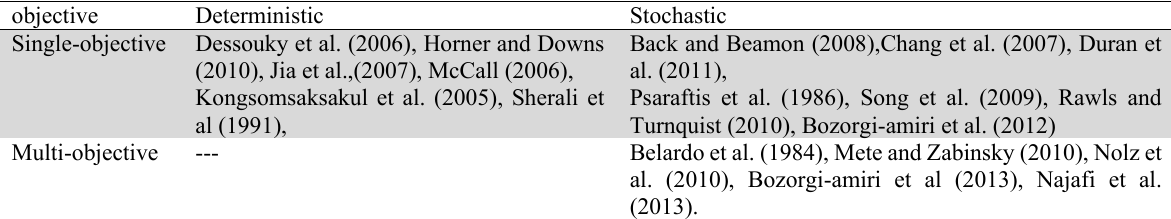
Structure of facility location models based on the data type and number of levels and objectives objective Deterministic Stochastic Single-objective Dessouky et al. (2006), Horner and Downs Back and Beamon (2008),Chang et al. (2007), Duran et (2010), Jia et al.,(2007), McCall (2006), al. (2011), Kongsomsaksakul et al. (2005), Sherali et Psaraftis et al. (1986), Song et al. (2009), Rawls and al (1991), Turnquist (2010), Bozorgi-amiri et al. (2012) Multi-objective --- Belardo et al. (1984), Mete and Zabinsky (2010), Nolz et al. (2010), Bozorgi-amiri et al (2013), Najafi et al.